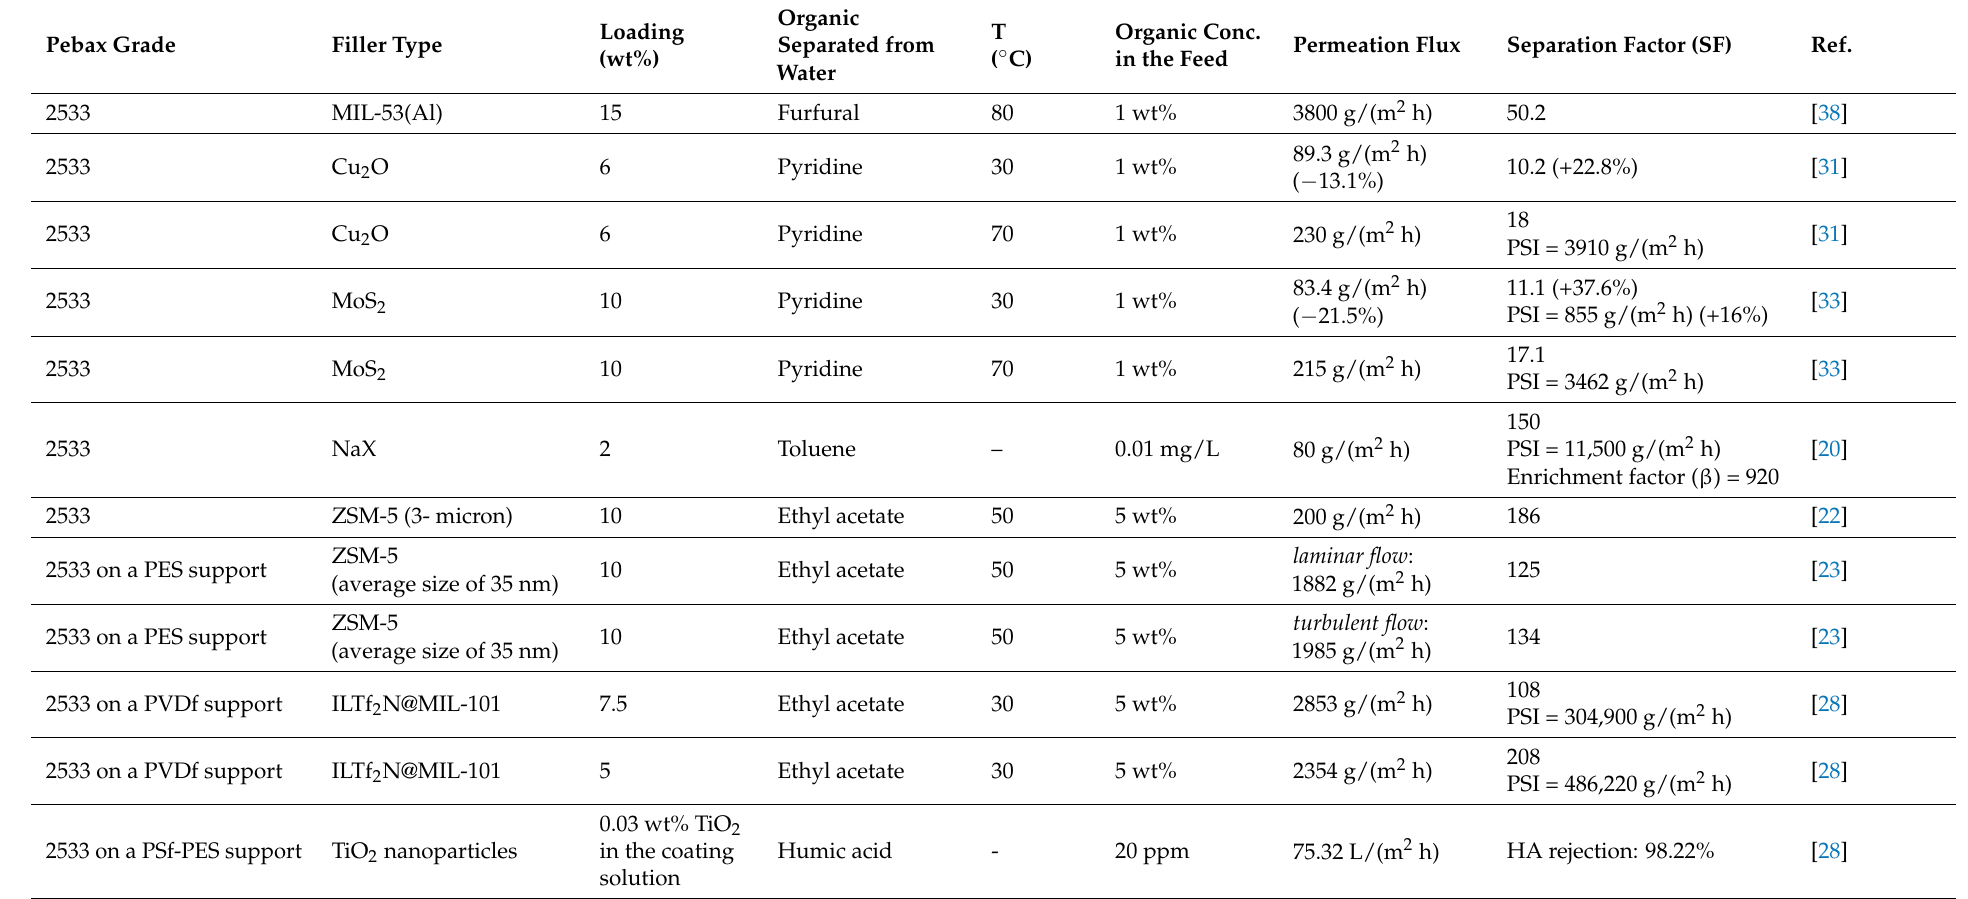
Table 6. Pervaporation performance of Pebax-based MMMs for water purification (removal of organic